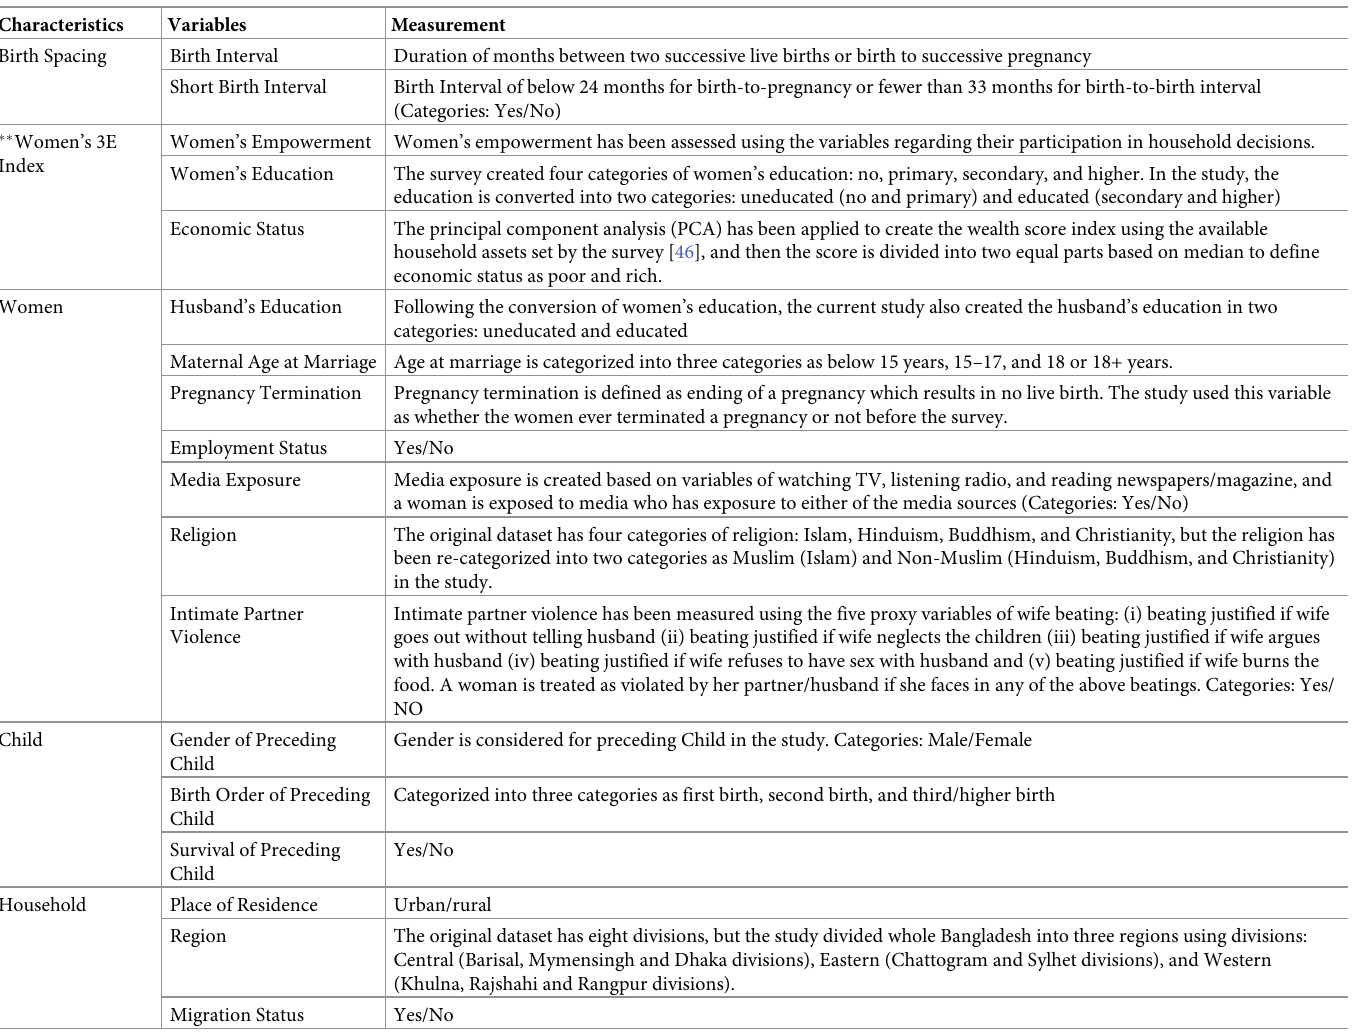
Table 1. Definition and measurements of the variables used in the study based on the 2017–18 BDHS.